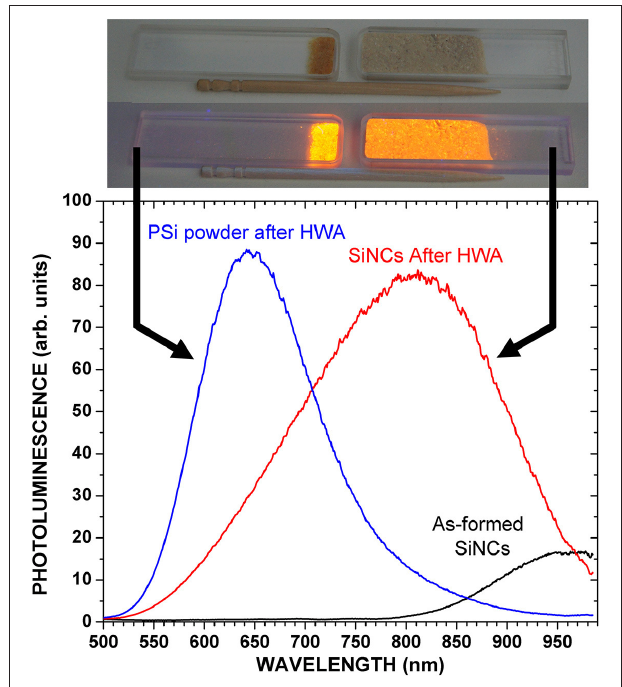
FIGURE 2 | PL of SiNCs powder before and after HWA, and of PSi powder after HWA. Excitation was 385nm. Pictures of the powders under a 365nm lamp (SLUV-8 from As One) are shown when the lamp was off and